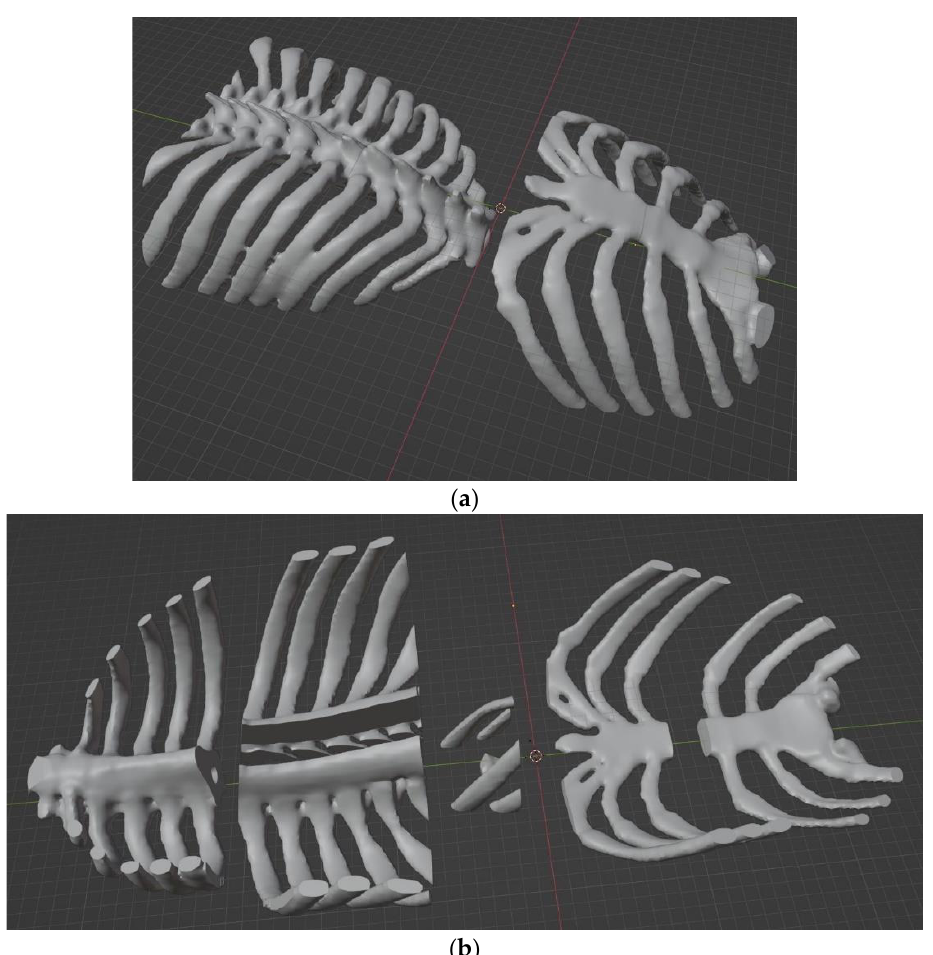
Figure 3. Ribcage models created from CT-scan data ( a ) Initial file received, produced from scan and cut in two ( b ) Further separated parts with modified orientation. Each of the separated parts can fit within the build volume of the printer being used.